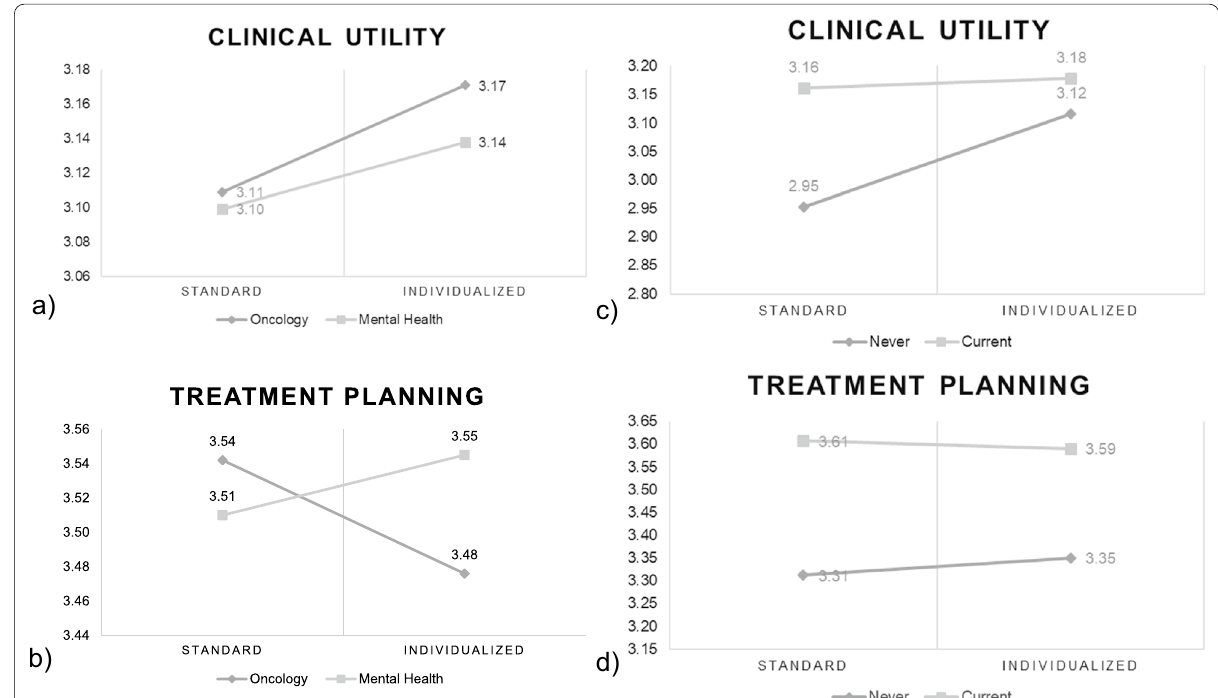
Fig. 1 Means for the Attitudes towards Standardized and Individualized Assessment scales by provider type ( a , b ) and user type ( c , d